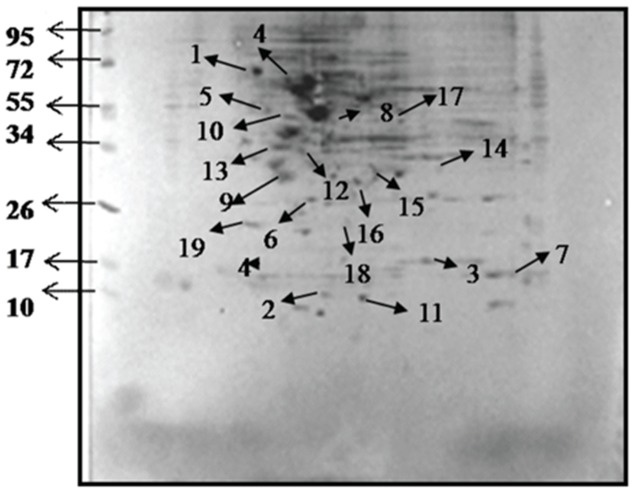
One representative image of 2D PAGE of the proteome of U87, cells in response to DMA, radiation and DMA+radiation treatment.Protein spots showing differential expression in the DMA, radiation and DMA+ radiation at 4 h time point, an average of three replicates (data derived from replicate wells) are annotated with arrows and numbers. The numbers given in this figure denote the 19 differentially expressed proteins identified by 2D PAGE and ESI-MS/MS analysis. The serial numbers 1–19 in table S1 denote the protein spots numbered in Figure 2. The left hand side spots are of protein marker.